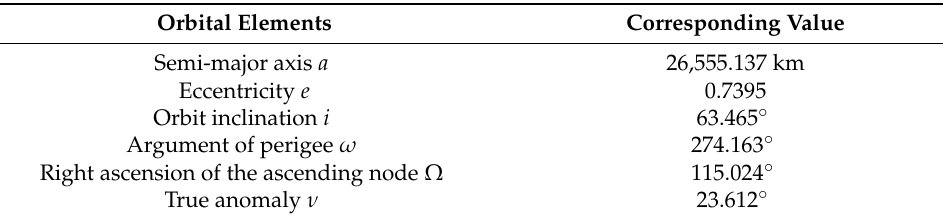
Table 2. Initial orbital elements of the chief spacecraft.